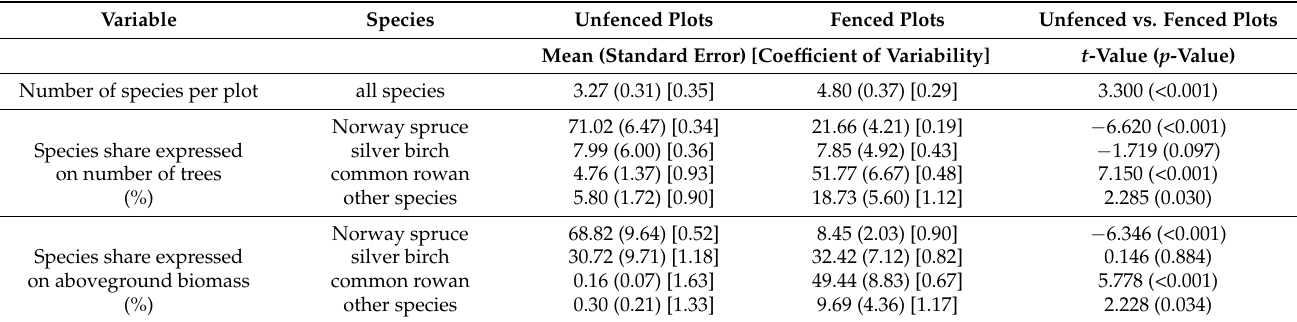
Table 4. A comparison of mean values, standard errors, and coefficients of variability for number of species per plot, species share expressed on number of trees (separately for Norway spruce, silver birch, common rowan. and other species), and species share expressed on aboveground biomass (separately for Norway spruce, silver birch, common rowan, and other species) between unfenced and fenced plots. Statistical differences were proved by Student’s t -test. Variable Species Unfenced Plots Fenced Plots Unfenced vs. Fenced Plots Mean (Standard Error) [Coefficient of Variability] t -Value ( p -Value) Number of species per plot all